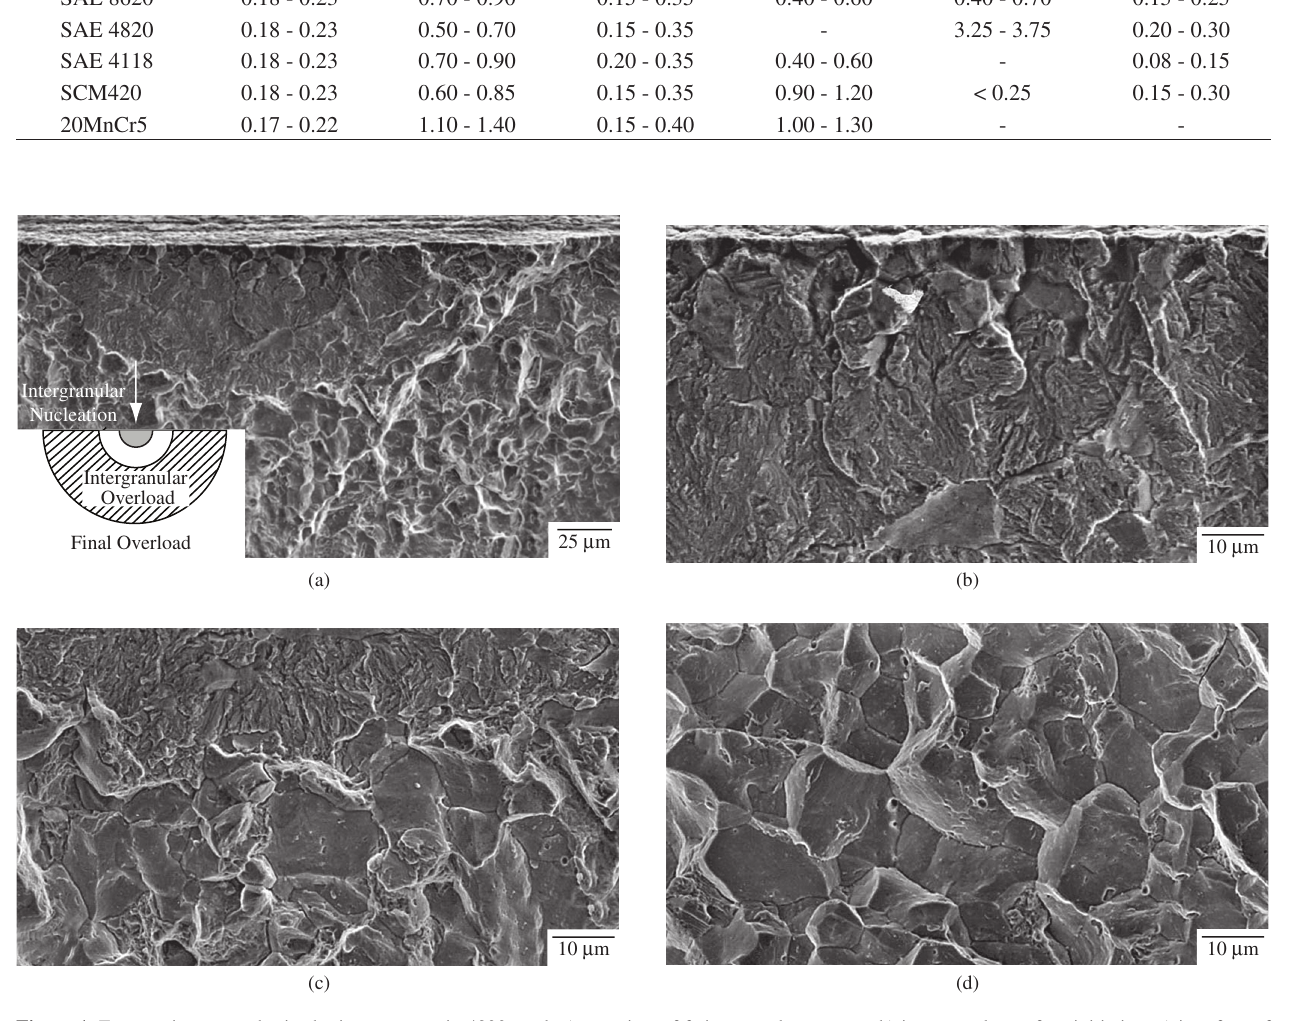
Figure 1. Fracture in case carburized microstructure in 4820 steel: a) overview of fatigue crack sequence; b) intergranular surface initiation; c) interface of transgranular and intergranular cracks; and d) overload intergranular fracture 9